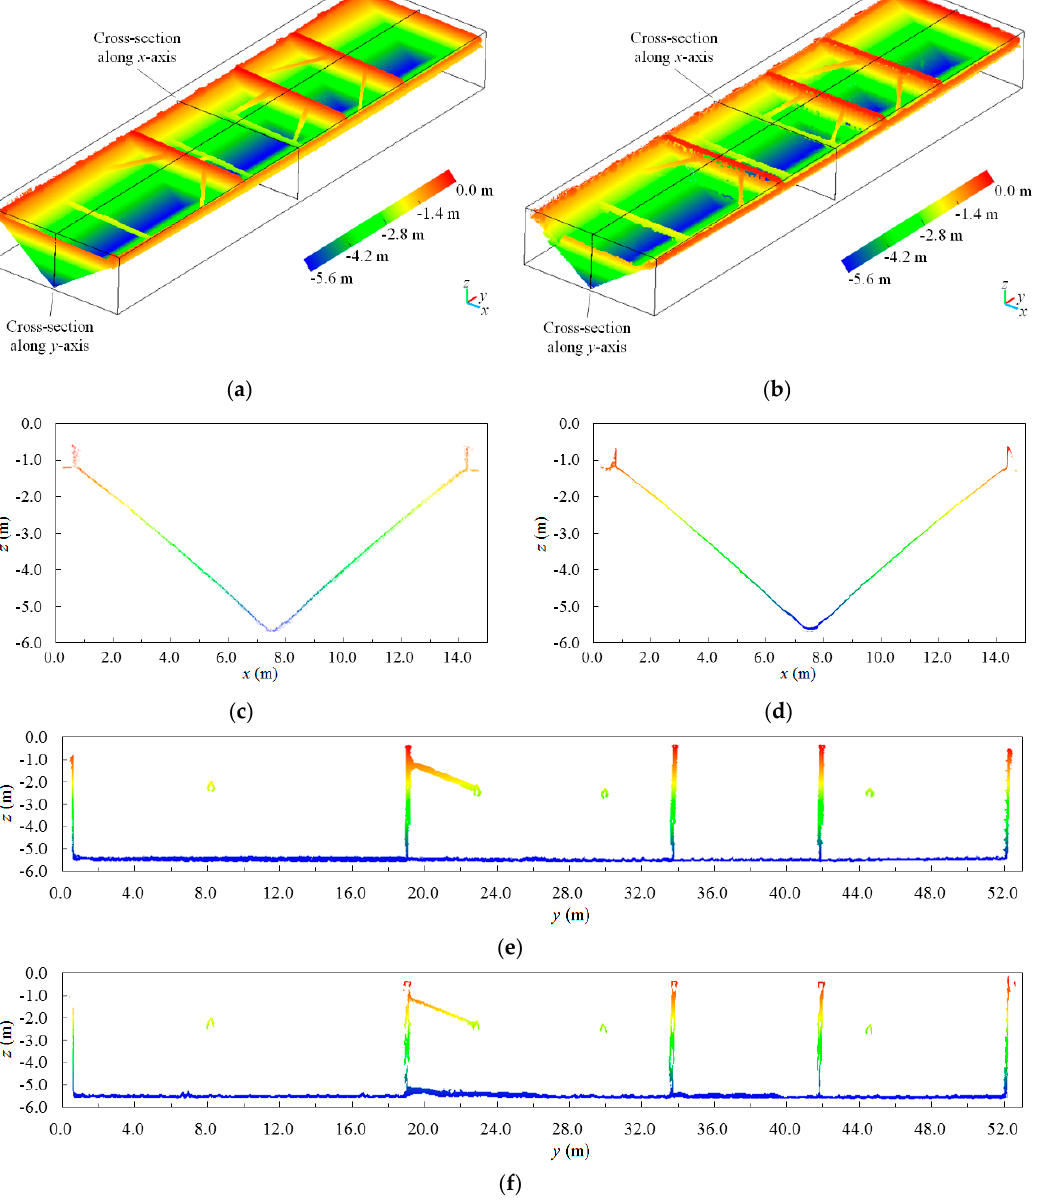
Figure 12. Comparisons of point clouds generated from laser scanning and UAV photogrammetry for stockpile-free modeling: ( a ) and ( b ) are the point clouds generated from laser scanning and UAV photogrammetry, respectively; ( c ) and ( d ) are the respective cross sections of ( a ) and ( b ) along the x-axis; ( e ) and ( f ) are the respective cross sections of ( a ) and ( b ) along the y-axis.